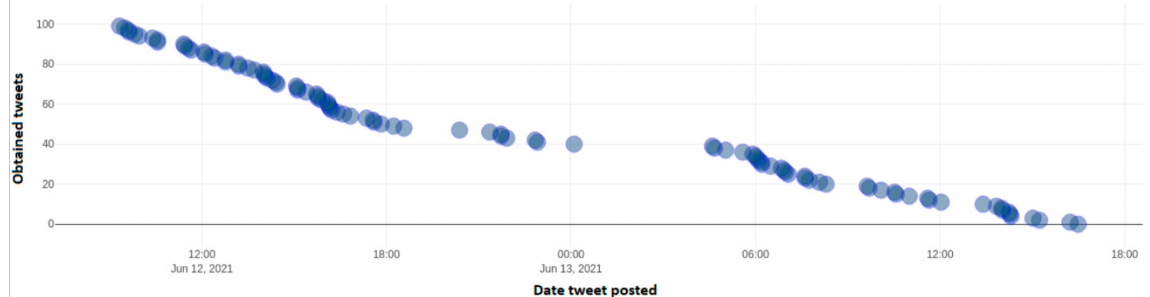
Figure 17. Mined tweets based on negative hashtag (#N ∆ _ θελατε ) (100 tweet sample) for New Democracy